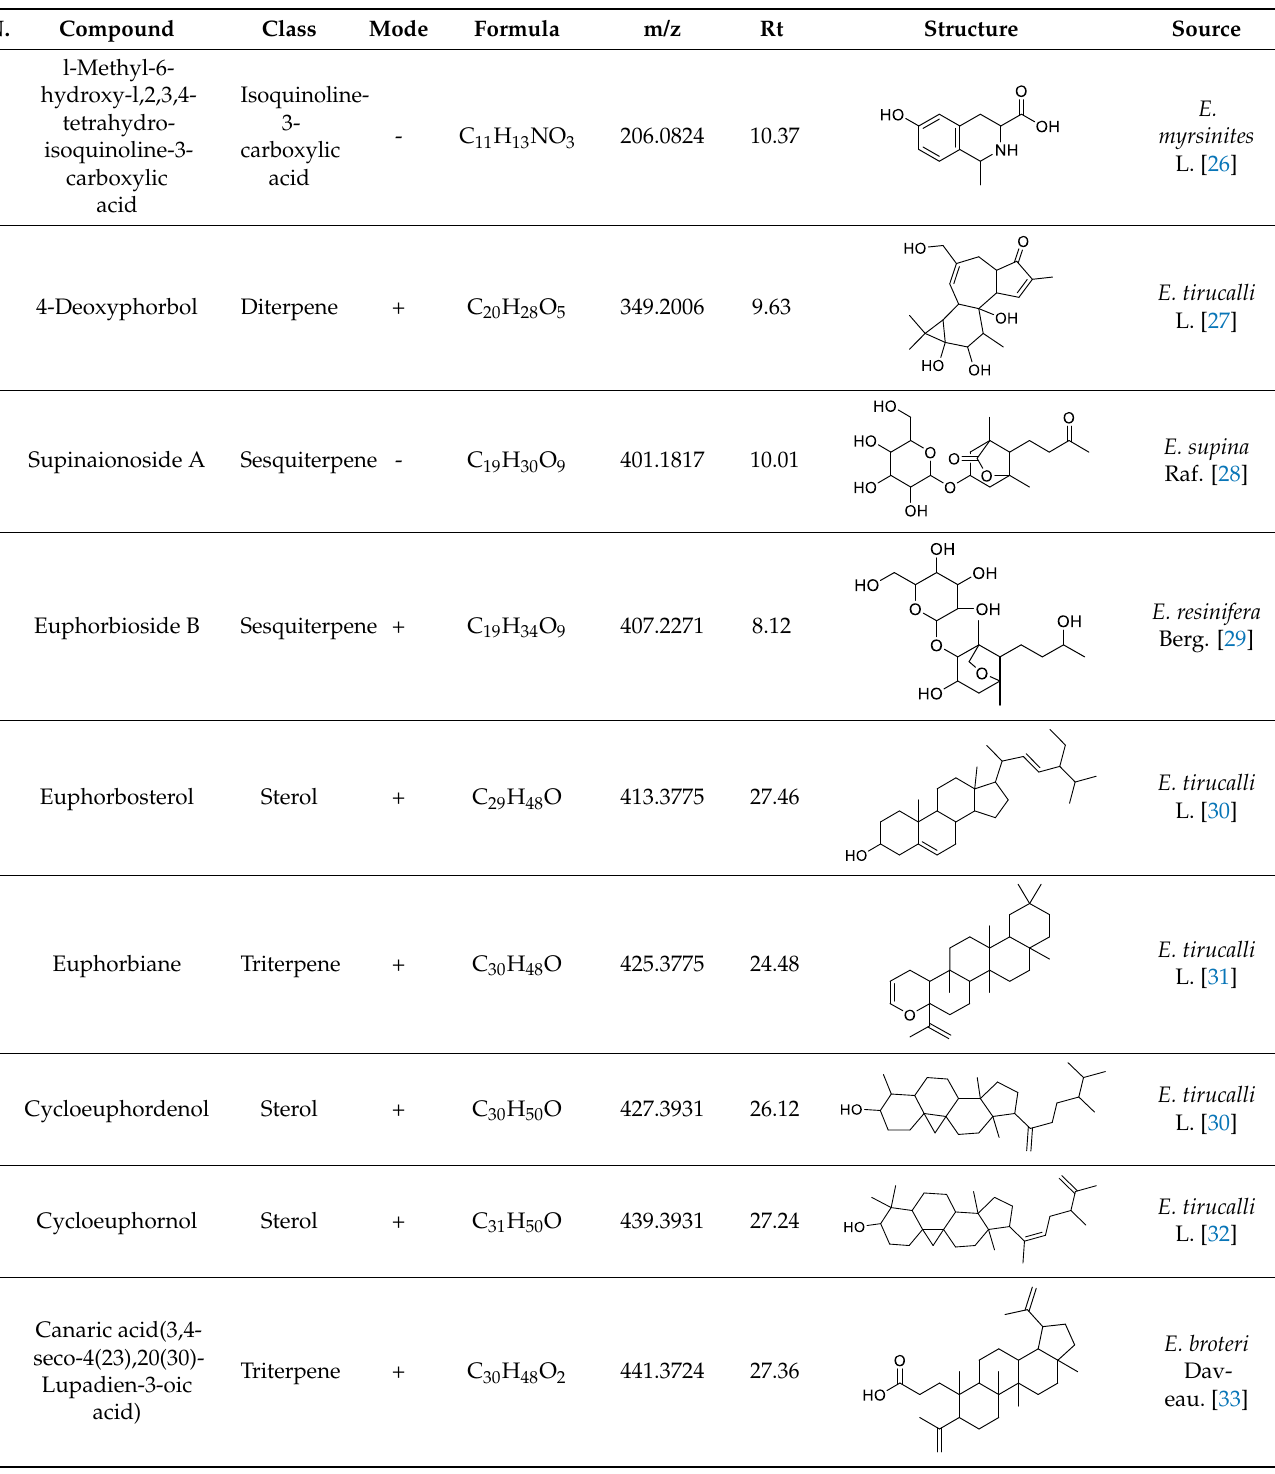
Table 2. List of secondary metabolites isolated from fifteen Euphorbia species.